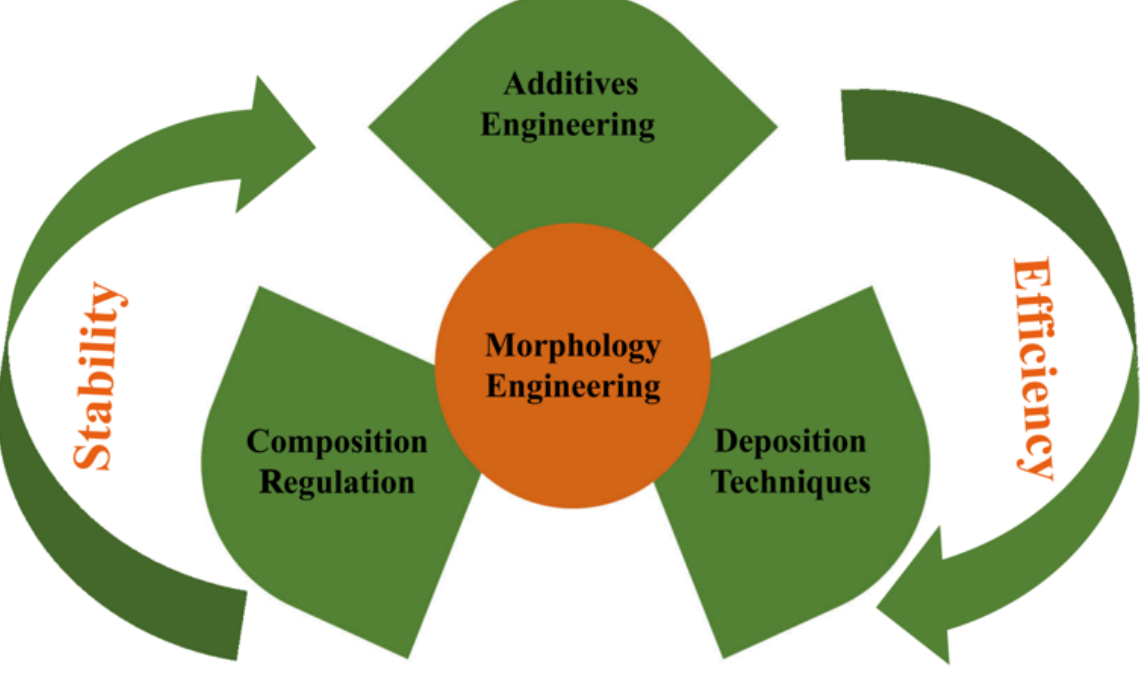
Figure 1. Classification of morphology engineering technologies for CsSnI 3 PVSCs.